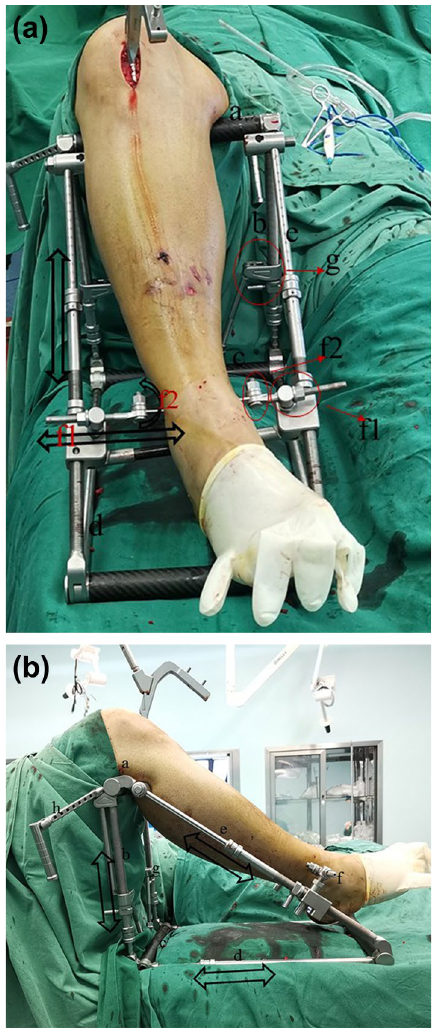
Figure 2. The application of the multiplanar fracture redactor in the treatment of tibial shaft fractures with intramedullary nails, ( a ) The antero-posterior view, ( b ) the lateral view. And the black arrow represents the direction of